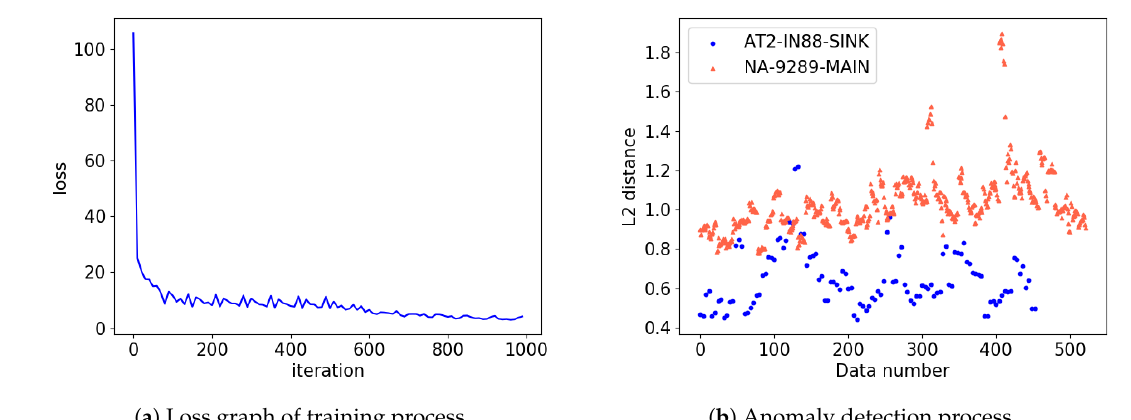
Figure 6. Results of the training and detection process. When GTX 1060 3 GB for 1 k iteration with